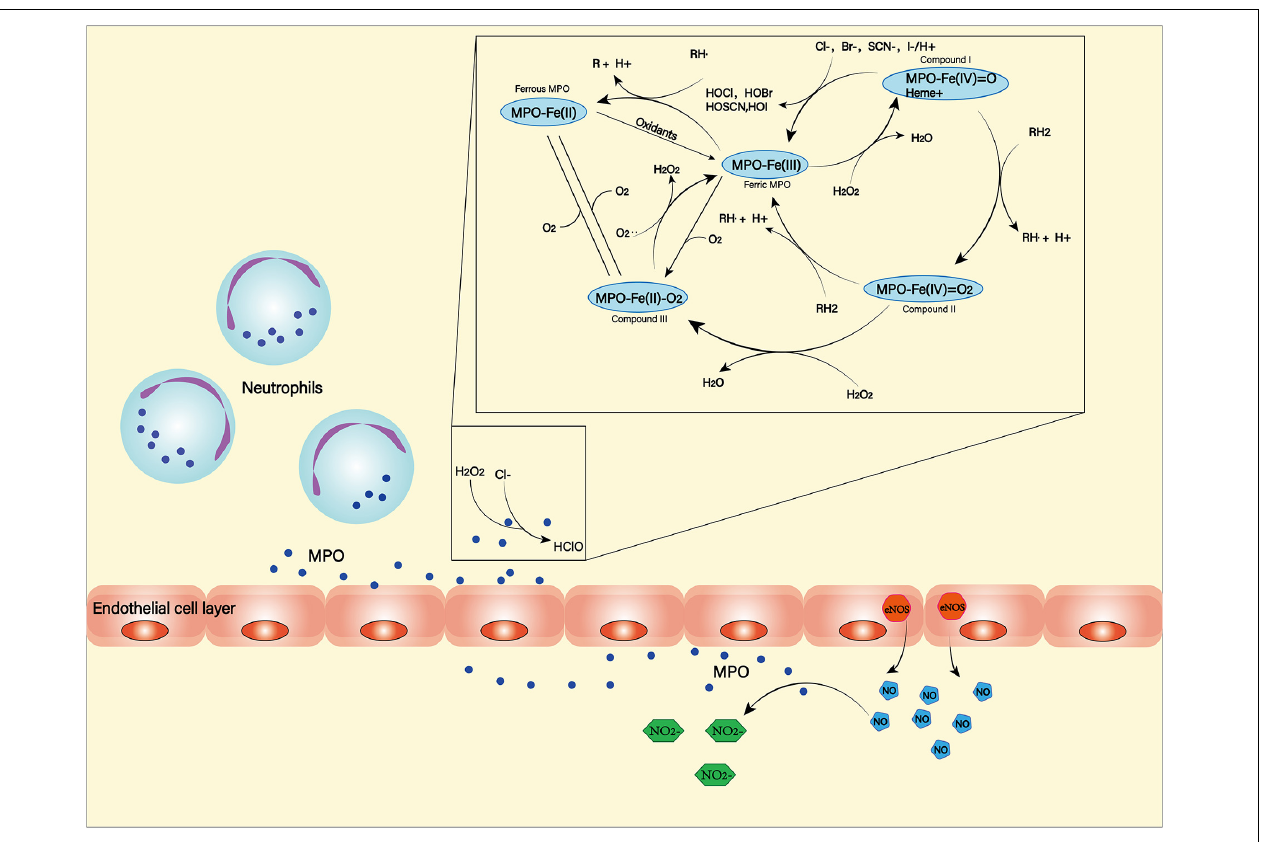
FIGURE 5 | Myeloperoxidase (MPO) is produced and secreted mainly by neutrophils. It can produce a variety of oxidation products through halogenation cycle and peroxidation cycle and then cause damage to tissues and cells. In halogen cycle, MPO catalyzes halogen to produce HOCl and other strong oxides. In the peroxidation cycle, MPO can react with oxidizable molecules (RH) to form free radical intermediates. In addition, MPO can react with NO generated by NOS to form NO2 -